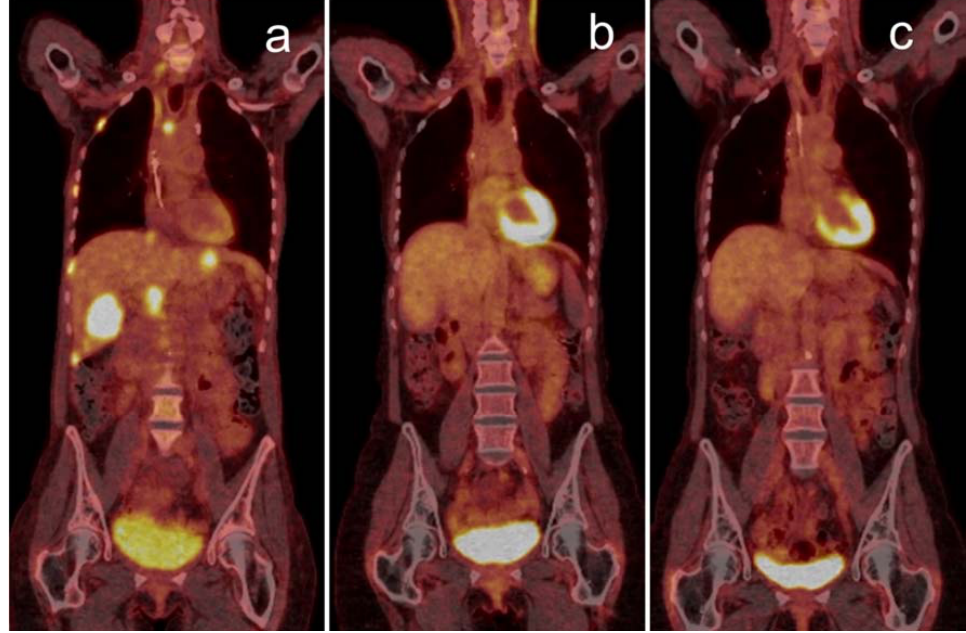
Figure 1. Complete metabolic response over two years visualized by PET / CT: 68-year-old woman with stage IV lung squamous-cell carcinoma (PD-L1 1%) having progressed after first-line chemotherapy, showing multiple liver, bone and lymph node metastases ( a ). The patient responded well to pembrolizumab monotherapy, with a PET / CT follow-up scan after one year ( b ) showing complete metabolic remission. Therapy was completed after two years, still in complete metabolic remission ( c ). PET / CT: positron emission tomography / computed tomography; PD-L1: programmed death ‐ ligand.